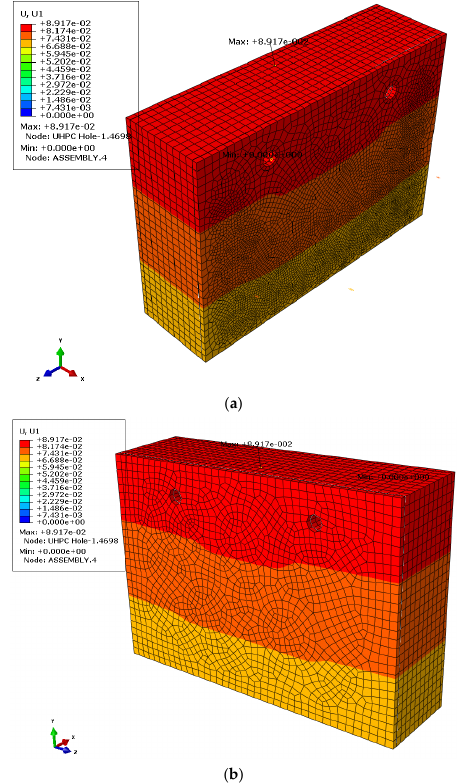
Figure 18. Concrete + steel displacements (U, U1) for ( a ) reaction (front) side and ( b ) forcing (rear) side. Appl. Sci. 2022 , 12 , x FOR PEER REVIEW